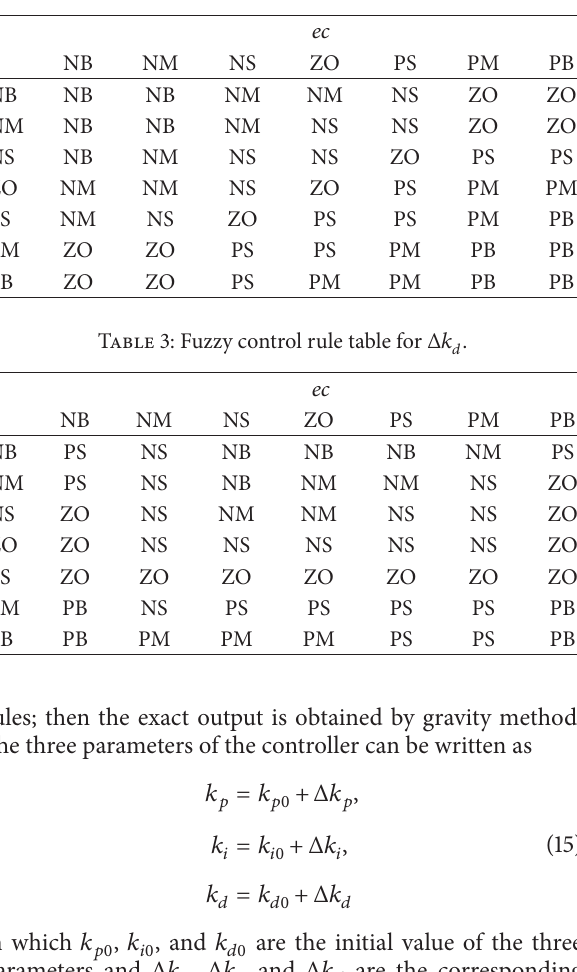
Table 1: Fuzzy control rule table for Δ𝑘 𝑝 . Table 2: Fuzzy control rule table for Δ𝑘 𝑖 .